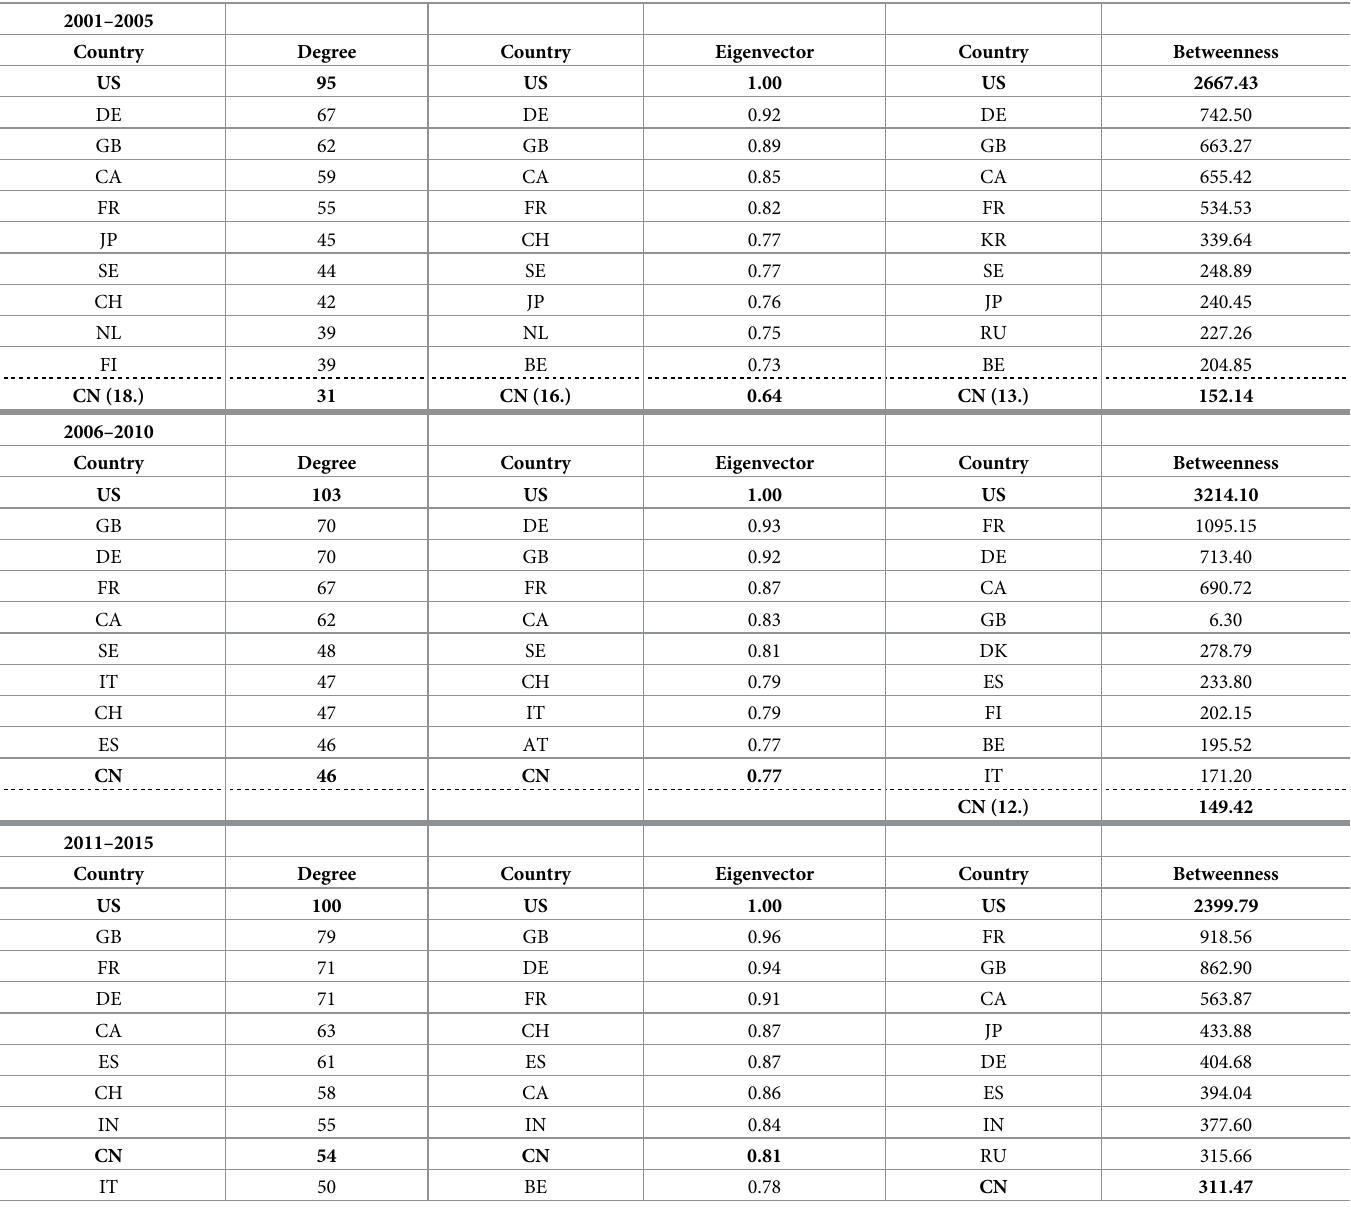
Table 2. Top ten centralities of countries in the global ICT network